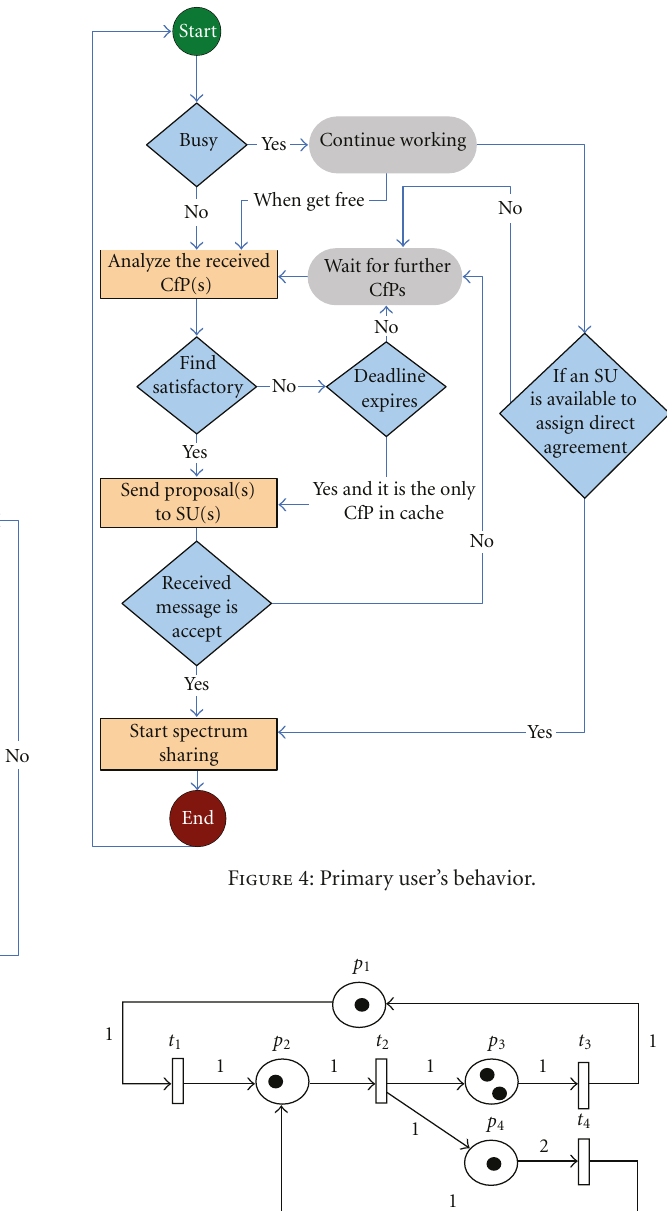
Figure 5: A simple PN with initial marking M o = { 1,1,2,1 }